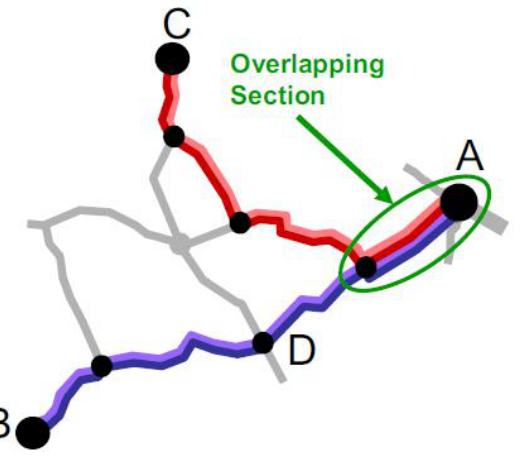
Figure 1. Overlapping train path line sections